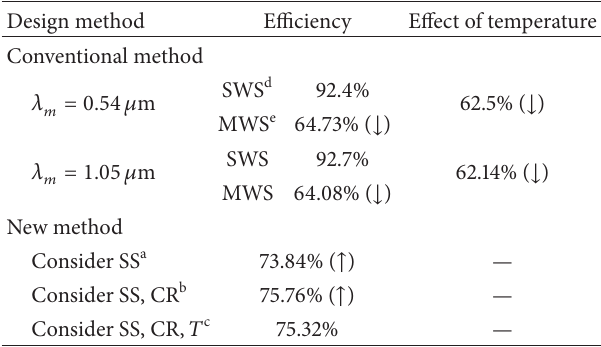
Table 1: The calculated energy efficiency of the conventional design and the novel design for entire Fresnel